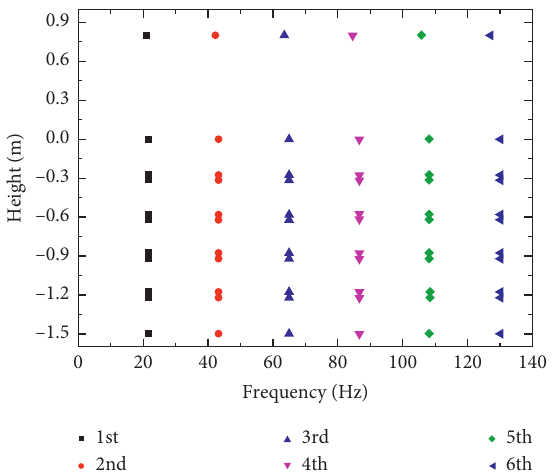
Figure 11: Evolution law of harmonic frequency along buried depth.